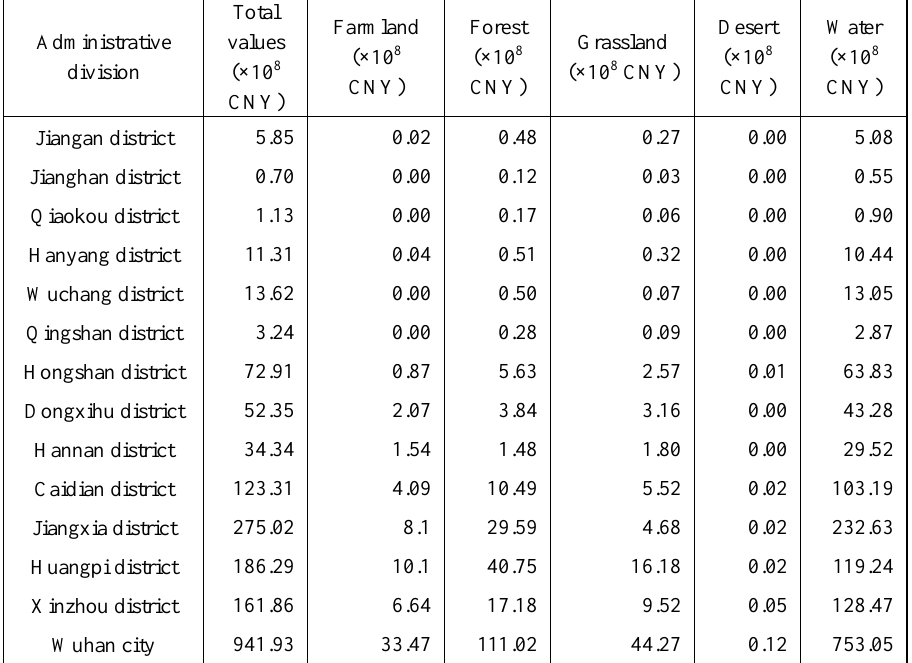
Table 2. Statistical analysis results of ESV from the view of terrestrial ecosystems